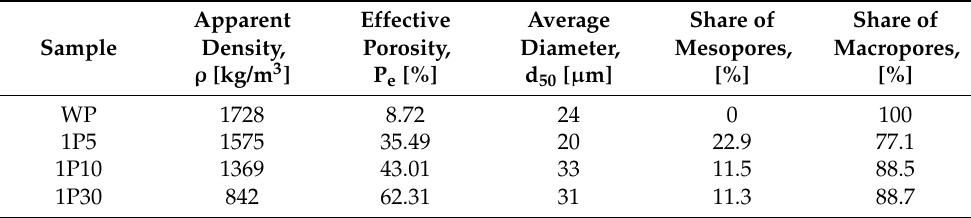
Table 2. Physical parameters of the pore space—quantitative assessment.